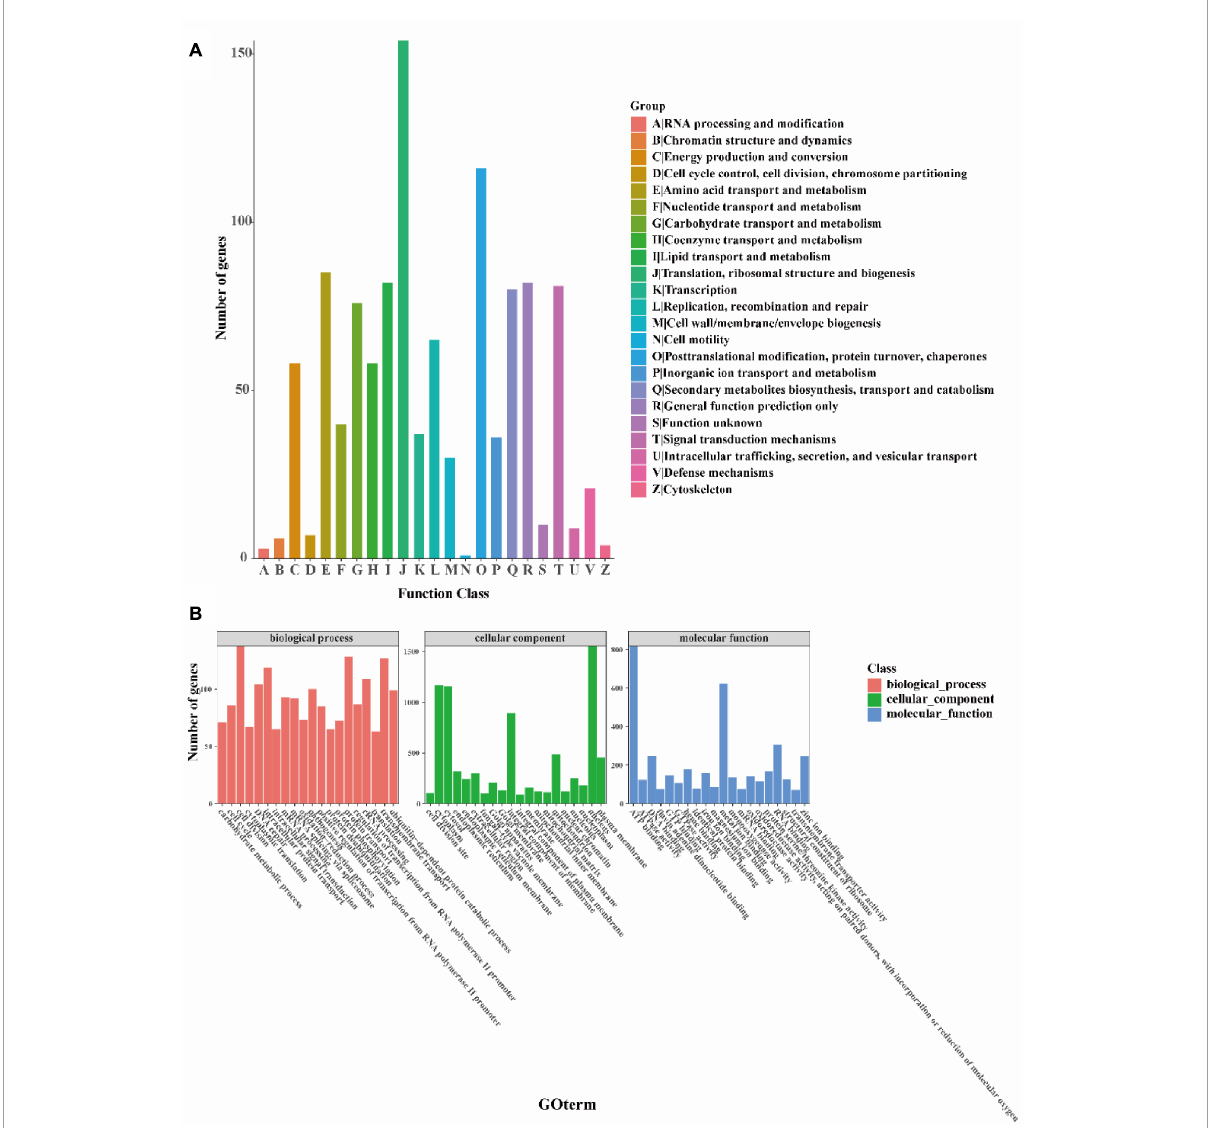
FIGURE5 Functional annotation of the I. hispidus genome. (A) COG feature annotation classification chart. (B) GO functional annotation classification statistics